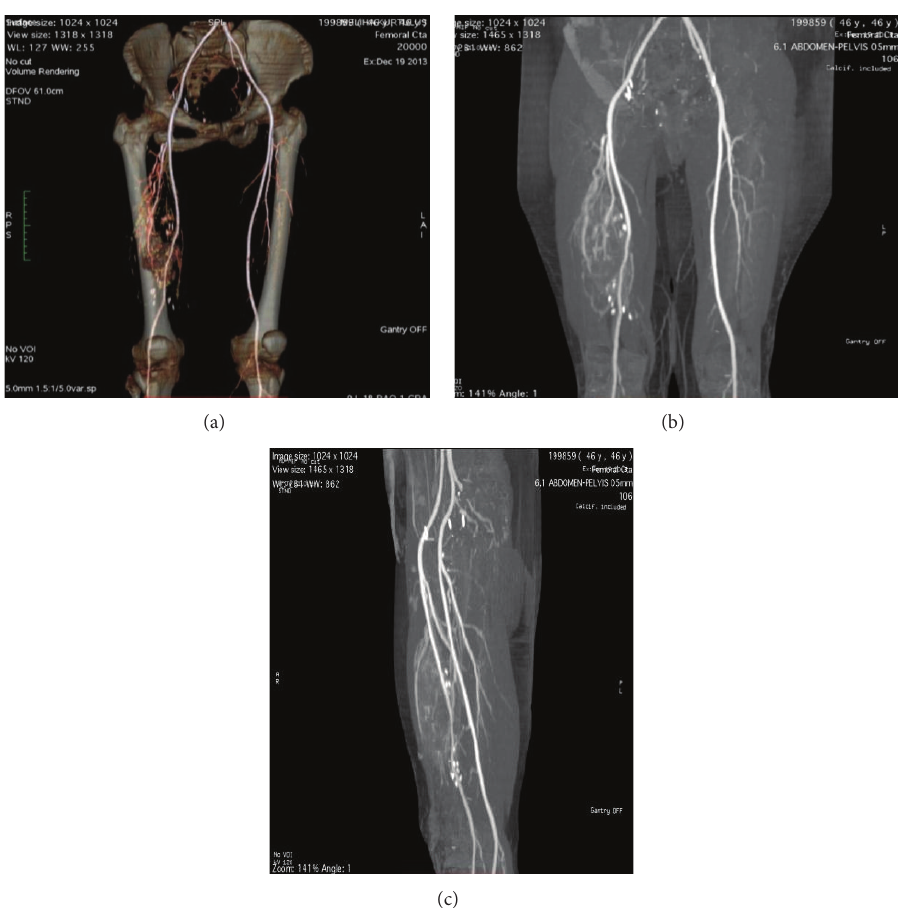
Figure 3: (a) Three-dimensional CT angiography. (b) Coronal plane CT angiography. (c) Sagittal plane CT